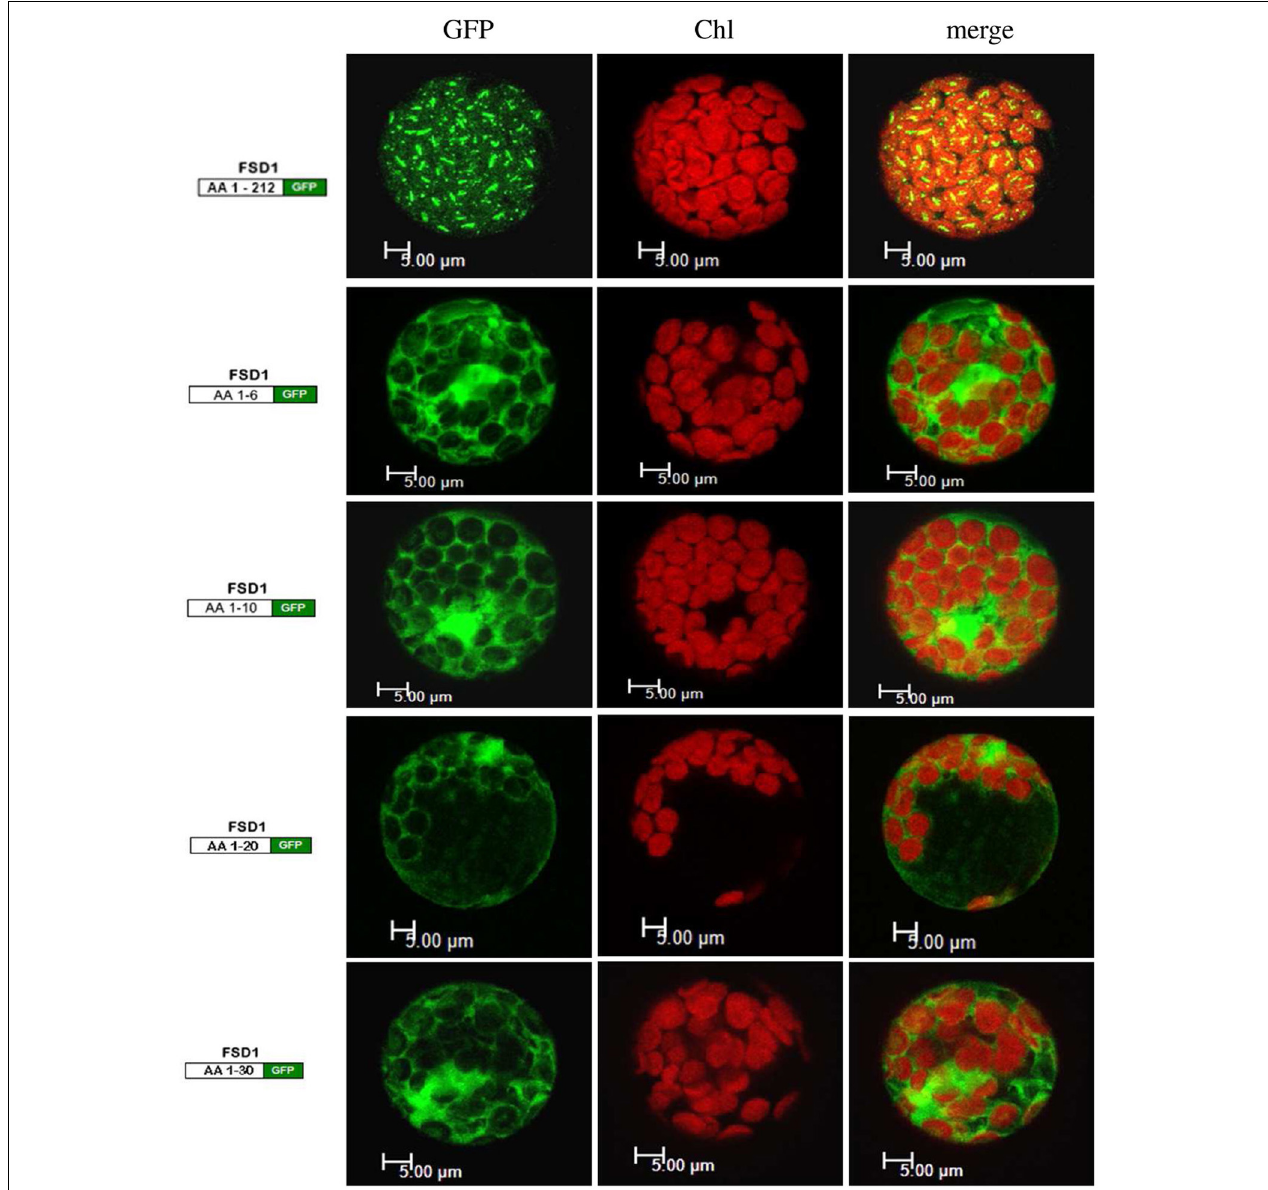
FIGURE 8 | The extreme N-terminus of FSD1 is not sufficient for guiding a reporter into chloroplasts. Arabidopsis mesophyll protoplasts were transiently transformed with C-terminal GFP fusions to either full-length FSD1 or the indicated number of N-terminal amino acids.